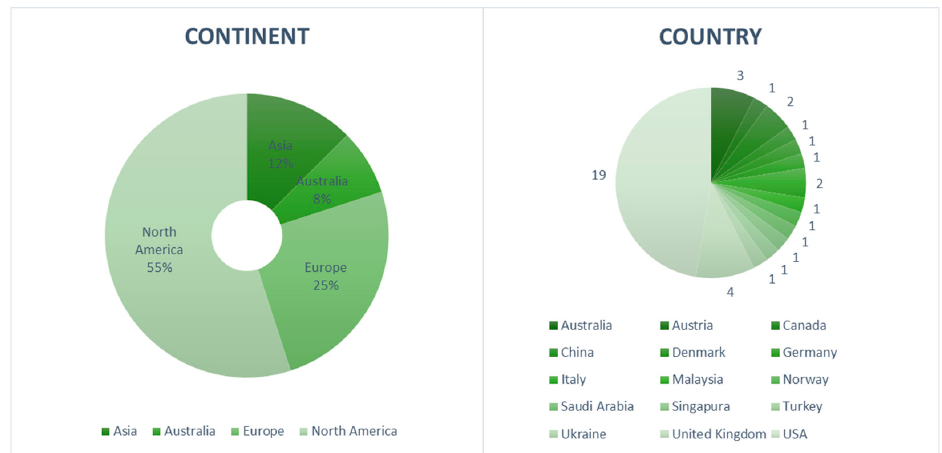
Figure 4. Geographic distribution of the sample.